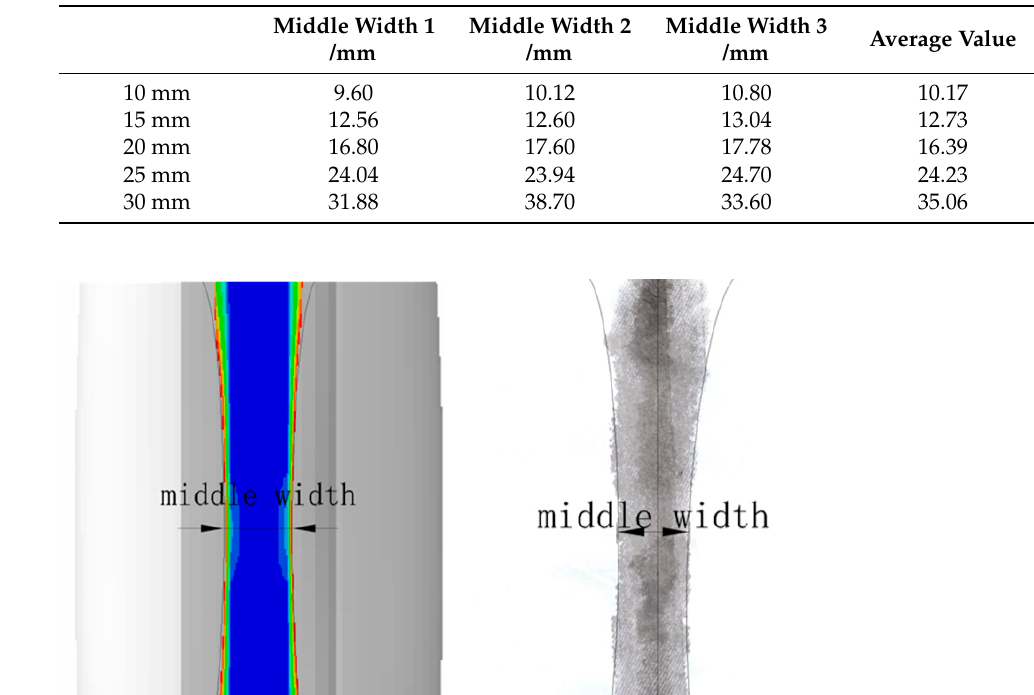
Table 2. The middle width results of the ink print tests.